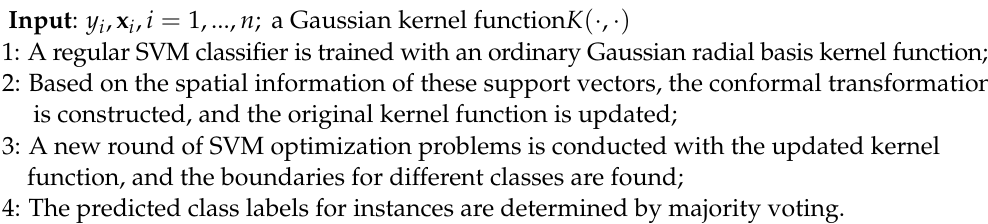
Algorithm 1. Multi-class data adaptive kernel scaling support vector machine